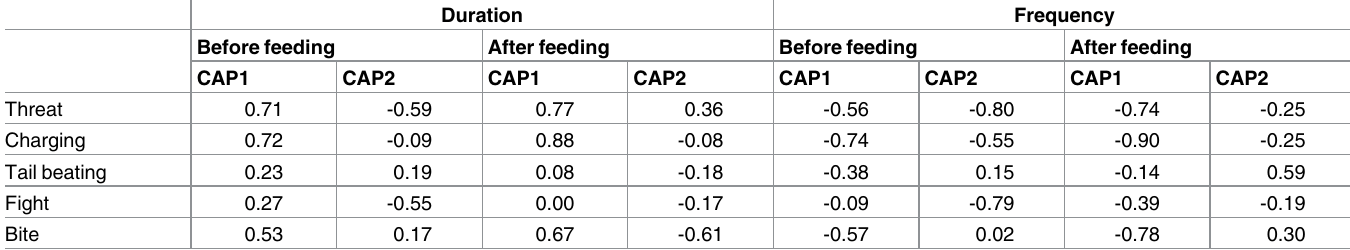
Table 2. Correlation values with axes best discriminating between treatments in the principal coordinate space. Pearson correlation coefficients for all behaviouralresponses with CAP 1 or CAP 2 (indicatedas vectors in Fig 1) as determinedby canonicalanalysisof